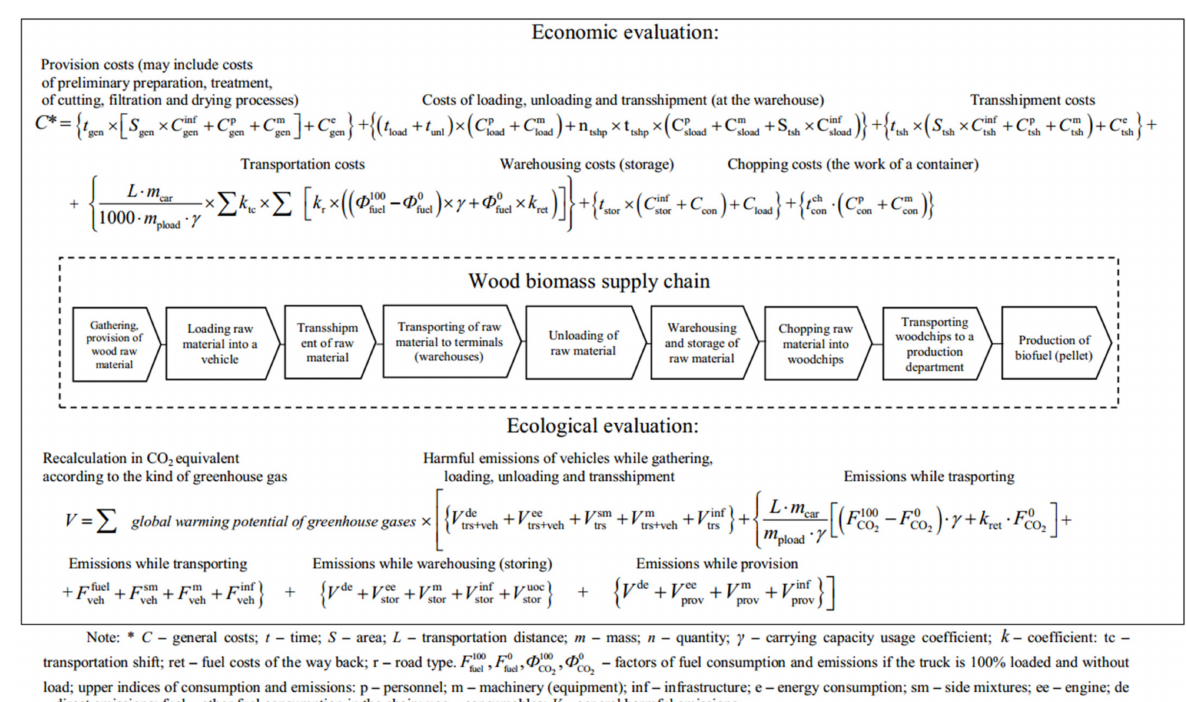
Figure 5. The model of the economic and ecologic evaluation of a wooden biomass supply chain. Source